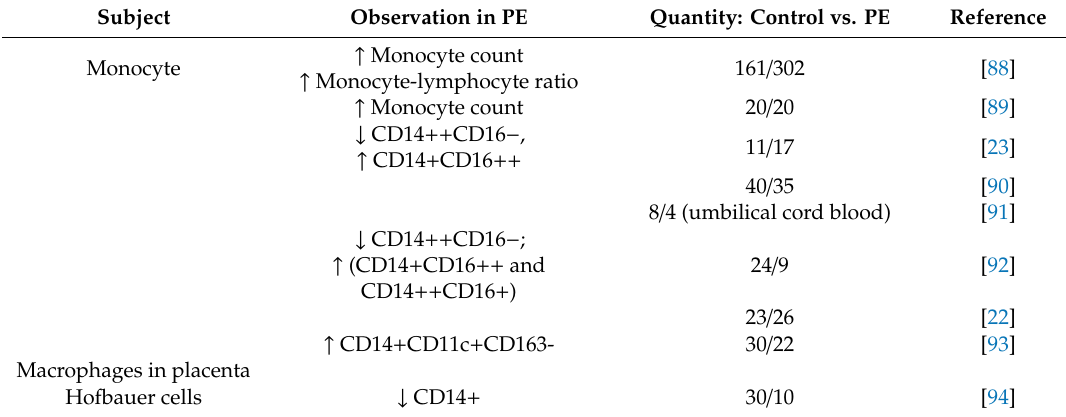
Table 1. Summary observations concerning monocyte–macrophage system in preeclampsia